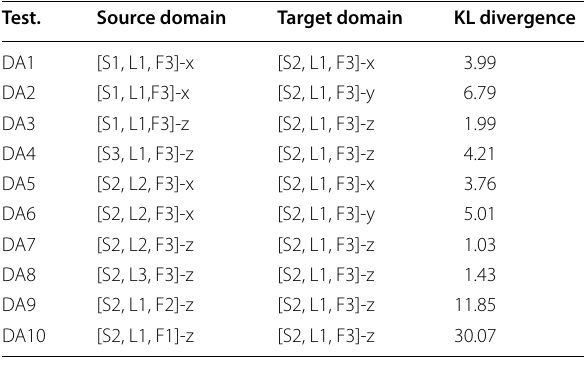
Table 2 Specific tests in experimental section